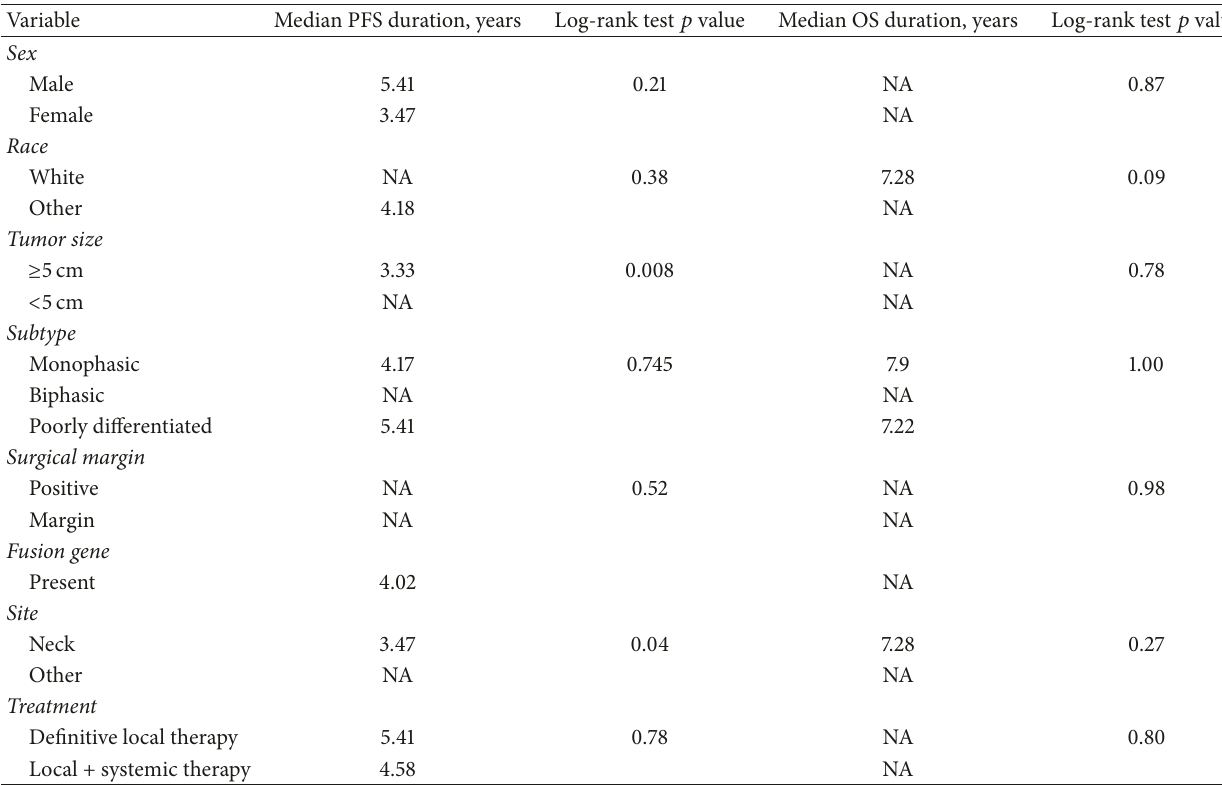
Table 2: Comparison of median survival